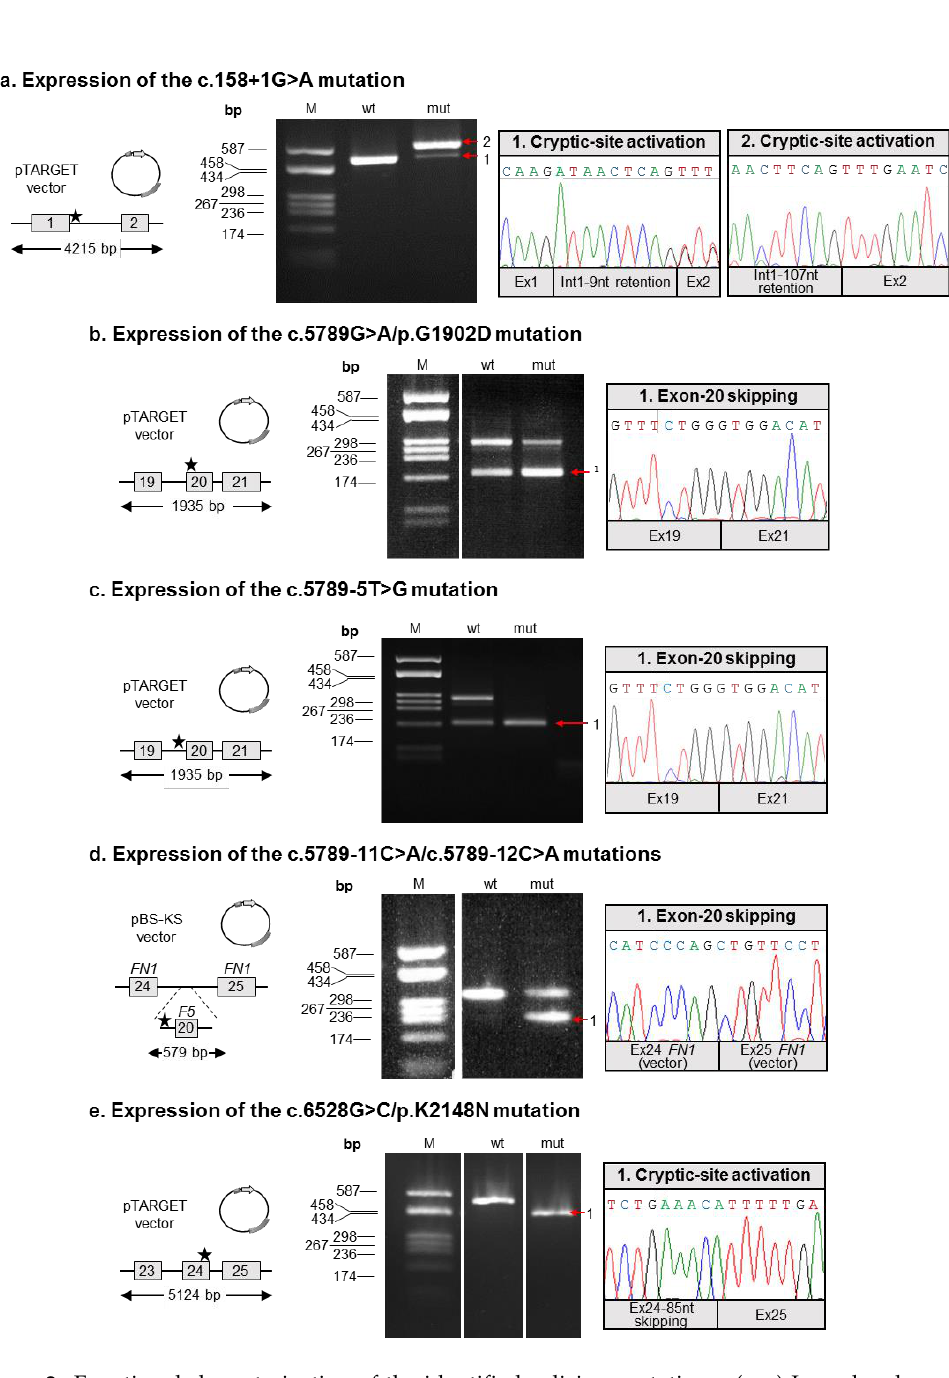
Figure 2. Functional characterization of the identified splicing mutations. ( a – e ) In each subgraph, the molecular characterization of a putative splicing mutation is reported (the name is indicated above the relevant panel). Left panels: Schematic representation of the F5 regions cloned into expression vectors (either pTARGET or the pBS-KS chimeric construct). Exons are numbered and indicated by boxes, introns are represented by lines; exons and introns are not to scale. The approximate position of the mutation is indicated by a star. Middle panels: RT-PCR products obtained from the RNA of cells transfected with the minigene constructs, separated on an agarose gel. M: molecular weight marker (pUC9/HaeIII); wt: RT-PCR product derived from transfected HeLa cells expressing the wild-type minigene; mut: RT-PCR product derived from transfected HeLa cells expressing the mutant construct. Right panels: Electropherograms showing the sequences of aberrant splicing events resulting from the analyzed mutations.